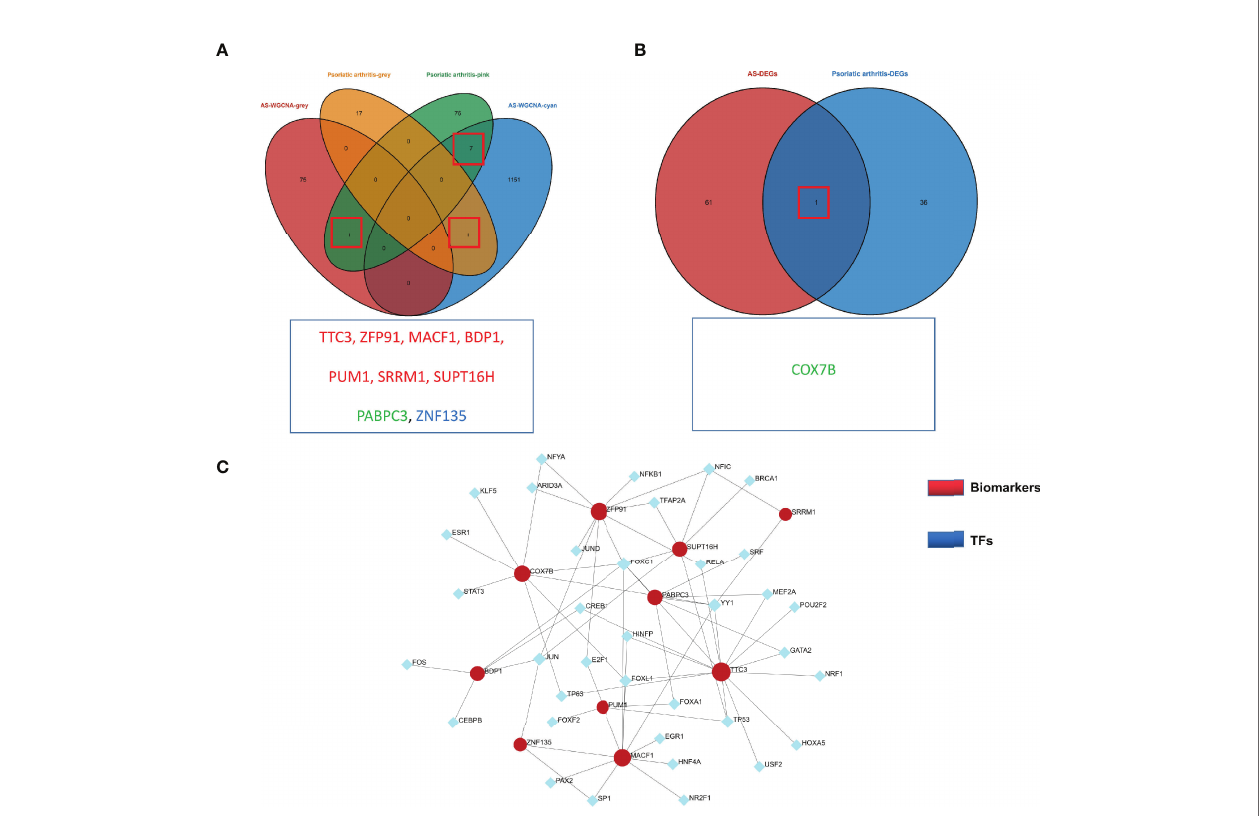
FIGURE 3 | (A) Venn diagram shows an overlap of 9 genes in modules between PsA and AS. (B) Venn diagram shows an overlap of one DEGs between PsA and AS. (C) TF-miRNA regulatory networks. Blue nodes represent transcription factors (TFs), and red nodes represent biomarkers. Black edges represent regulatory relationships between TFs and